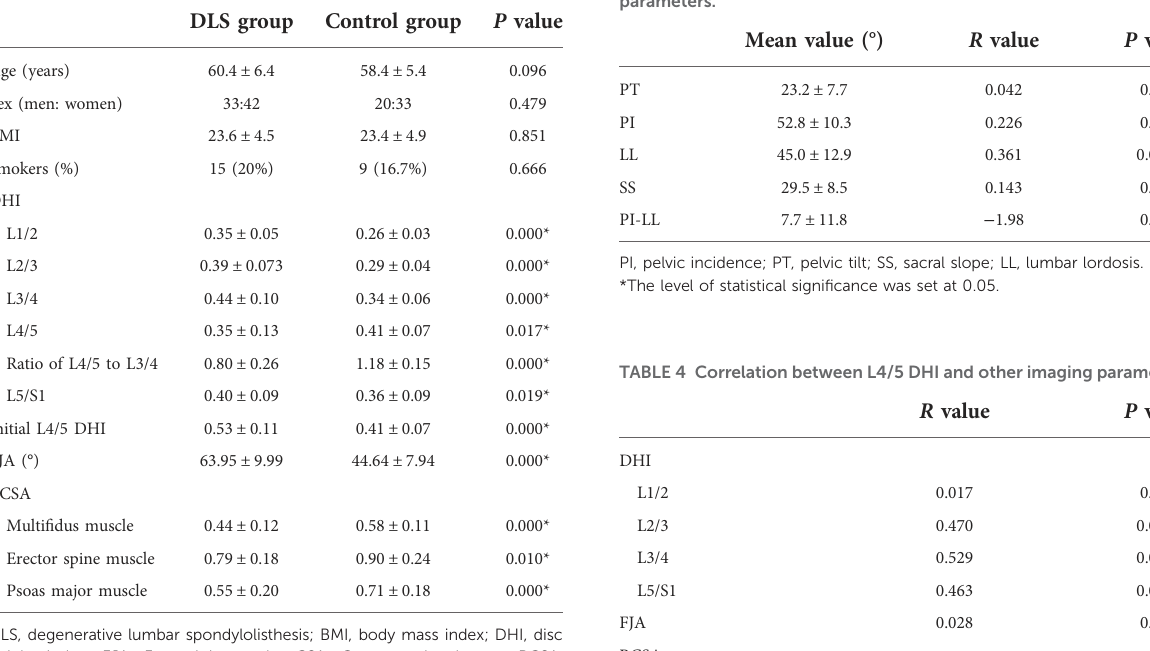
TABLE 1 Comparison of results between two groups ( x ±s).